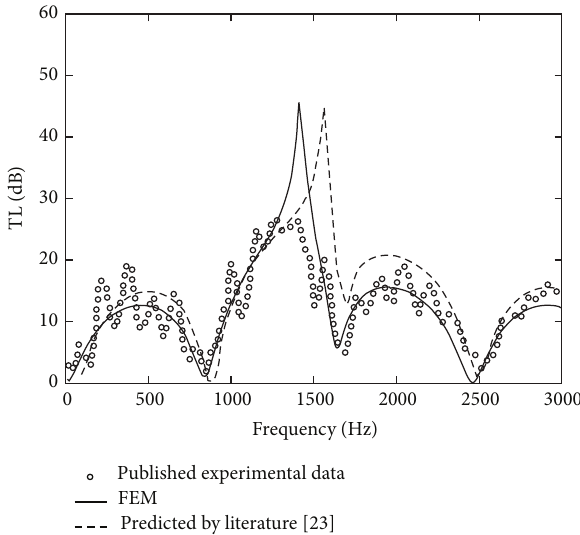
Figure 11: Measured and predicted TL for the expansion chamber silencer with inlet flow velocity of V = 10.2 m/s.